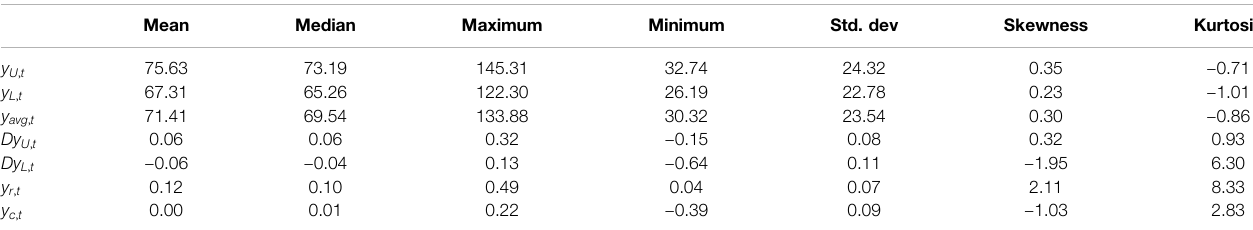
TABLE 1 | Basic statistical analysis on monthly interval-valued crude oil